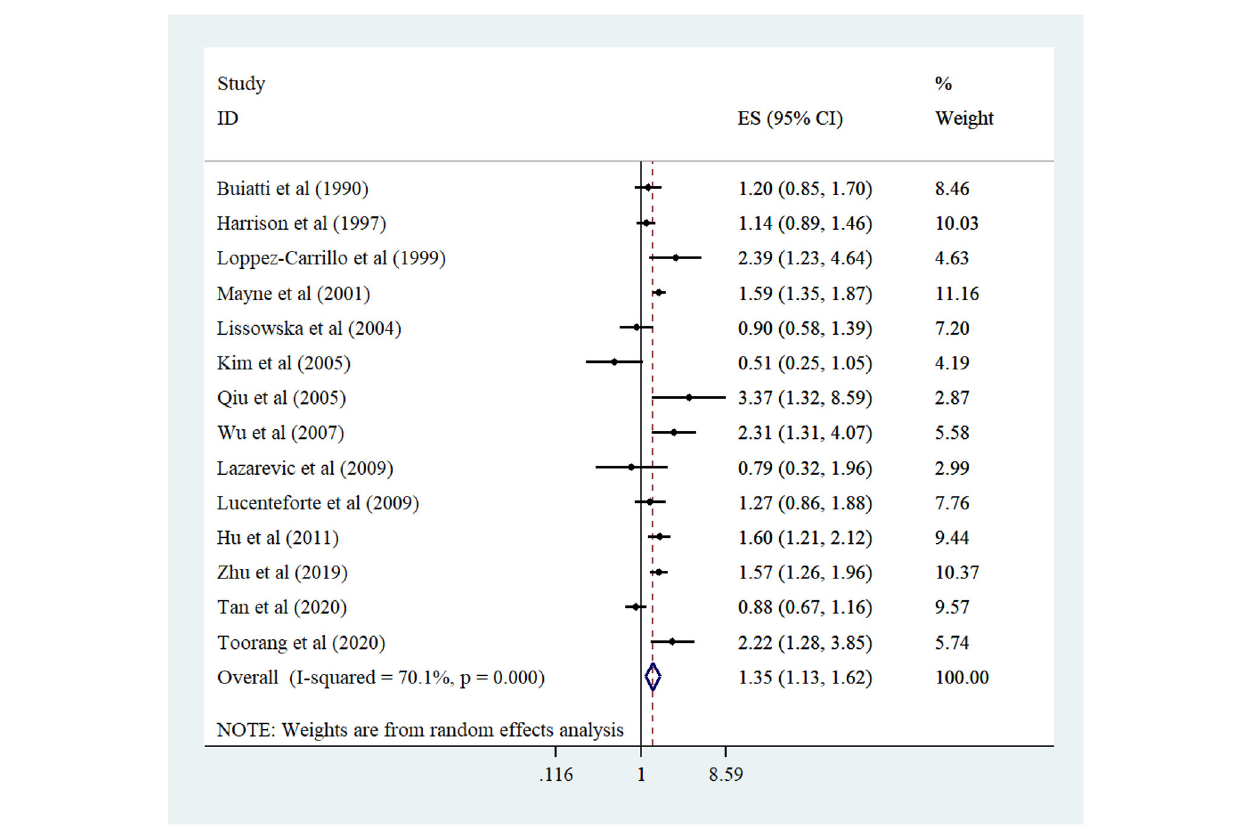
FIGURE 2 | Forest plot derived from random-effects meta-analysis of studies investigating the association between high vs. low intake of dietary cholesterol and gastric cancer in adults. CI, confidence interval; ES, effect